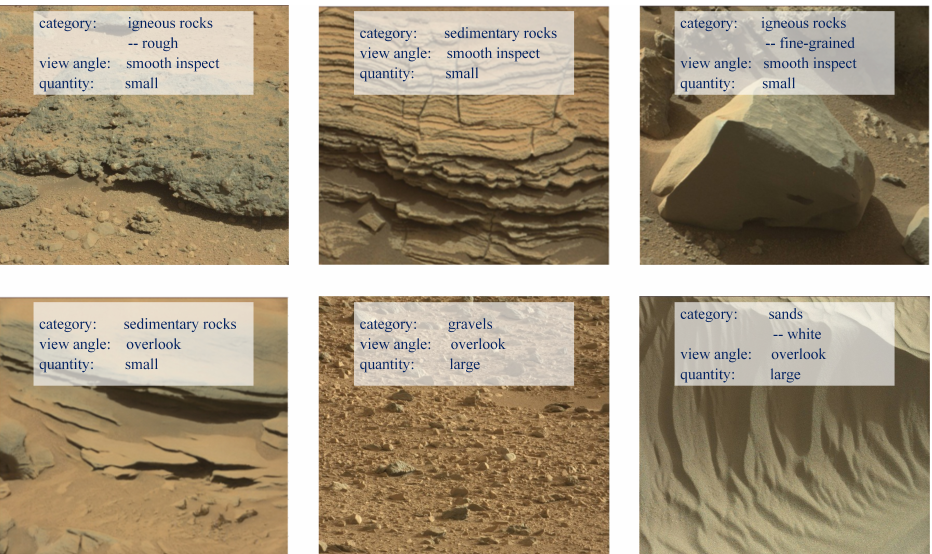
Figure 3. Examples of various spatial structures in our dataset. GMSRI includes a diverse set of 30,000 Martian rock images under different view angles and